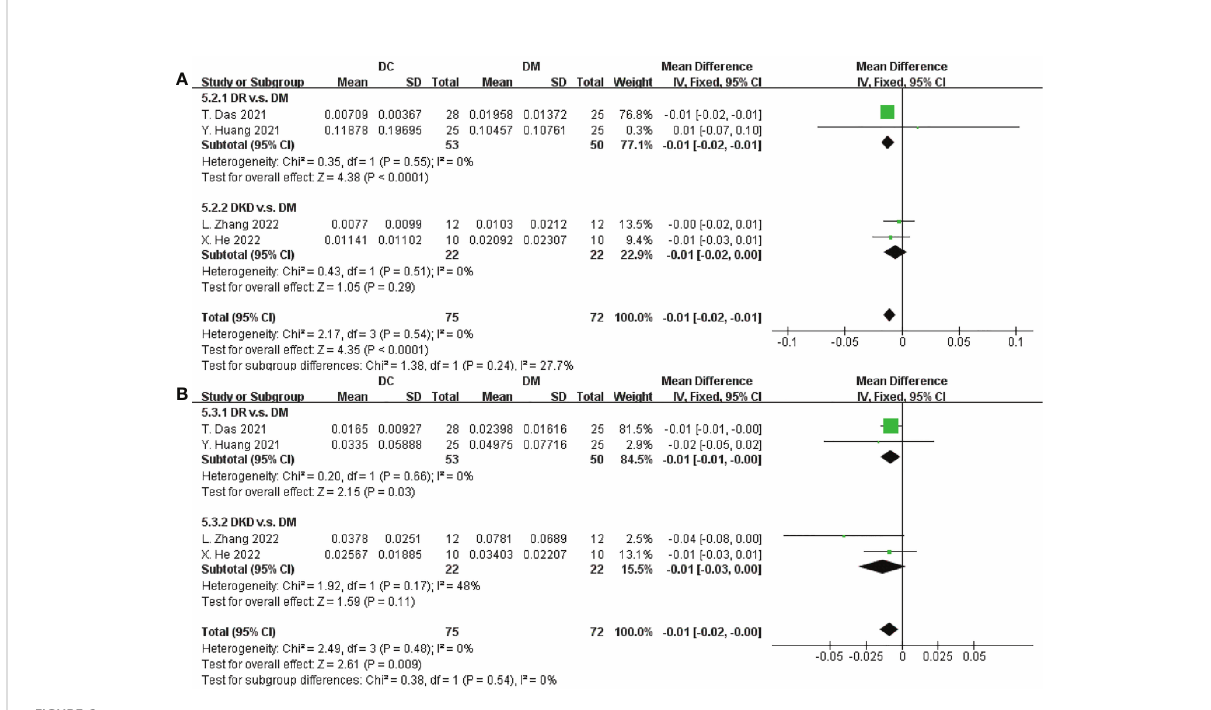
FIGURE 6 Forest plots of microbiota at the genus level in DC v.s. DM. (A) Bi fi dobacterium ; (B) Faecalibacterium .